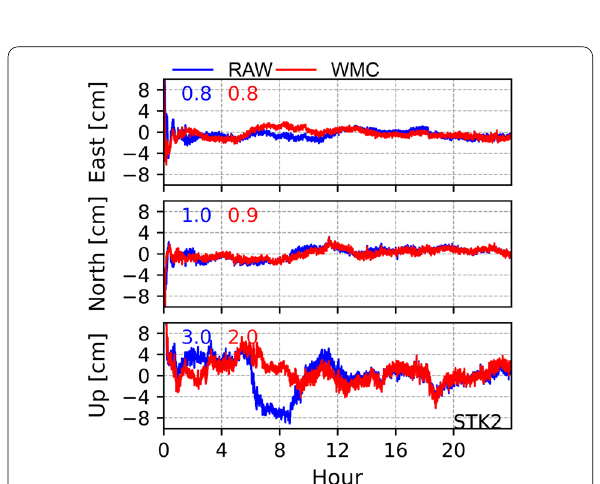
Fig. 13 Positioning error in the east, north, and up components of multi-GNSS integrated PPP in kinematic mode on January 1, 2018 for station